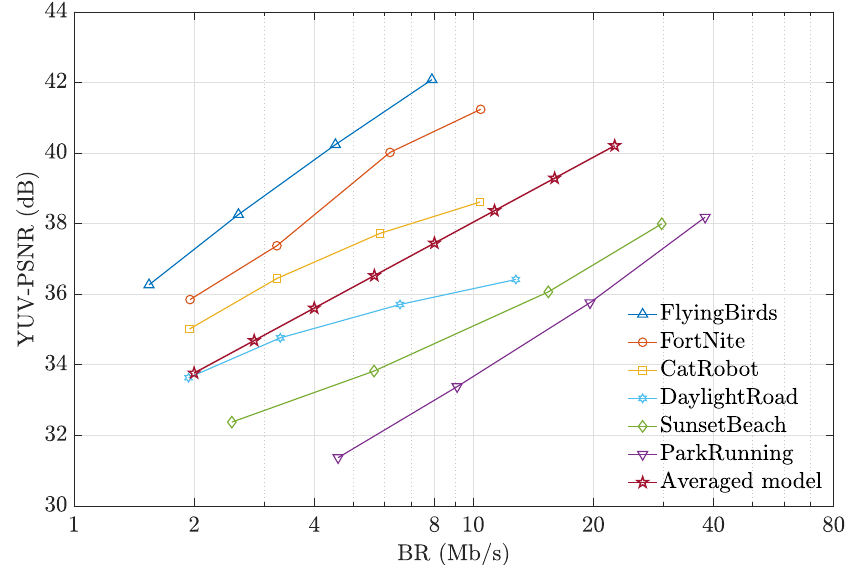
Figure 2. Essential Video Coding (EVC): Peak Signal-to-Noise Ratio (PSNR)–Bitrate (BR) data and linear Rate Distortion (RD) models for 3840 × 2160 resolution sequences. The averaged RD model is also displayed as red line with star markers.